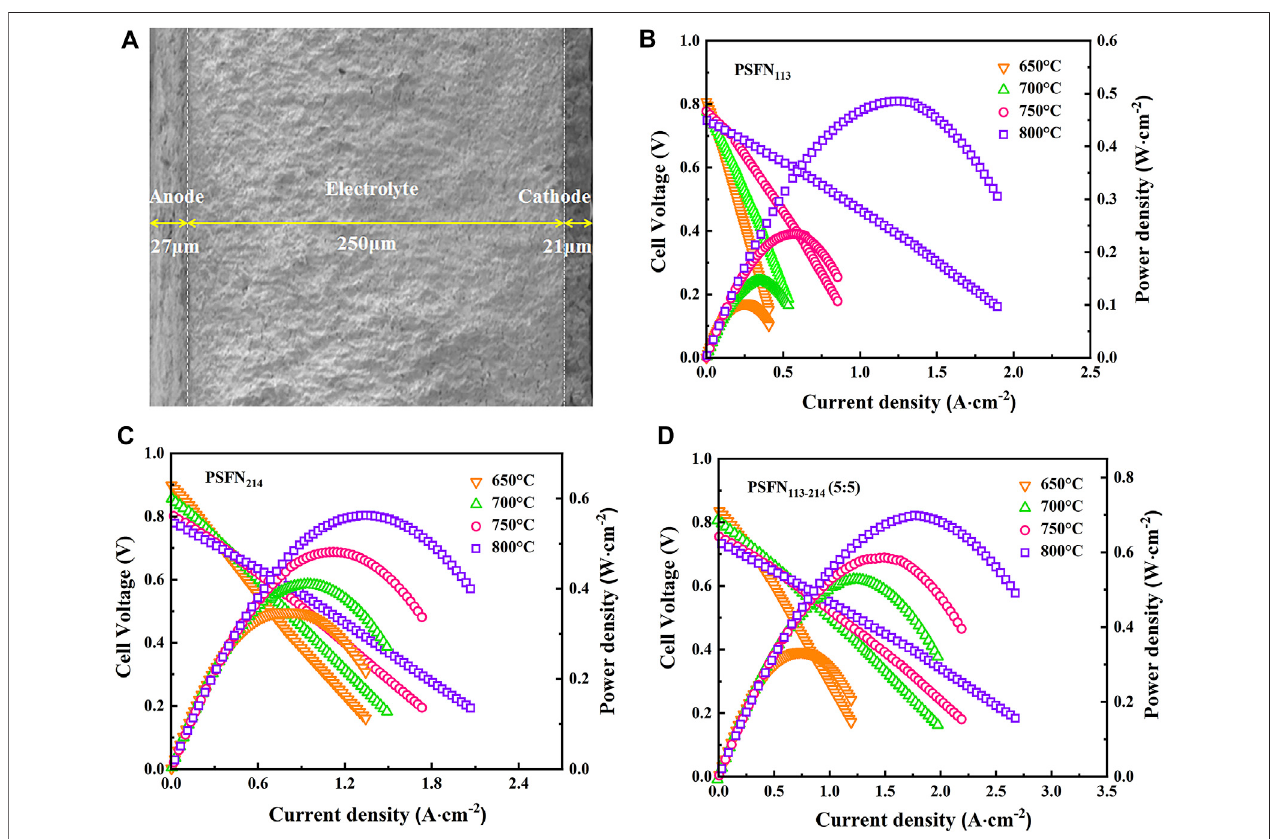
FIGURE 8 | (A) Cross-sectional morphology of a single cell and I-V-P curves: (B) PSFN 113 , (C) PSFN 214 , and (D) PSFN 113-214 (5:5).